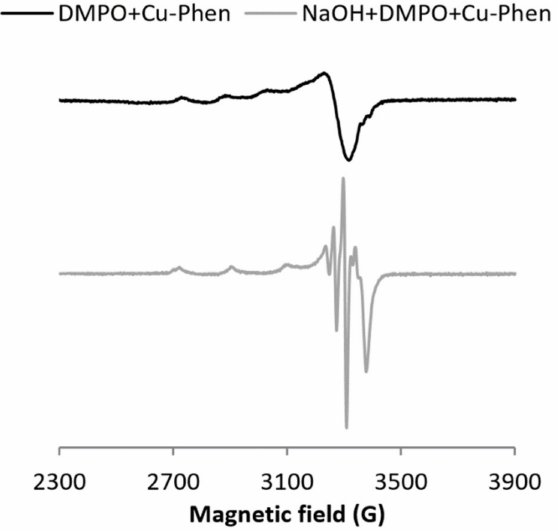
Figure 8. X-band EPR spectra at 100 K of DMPO + Cu–Phen with and without NaOH-[Cu] = 0.15 mM, [DMPO] = 60